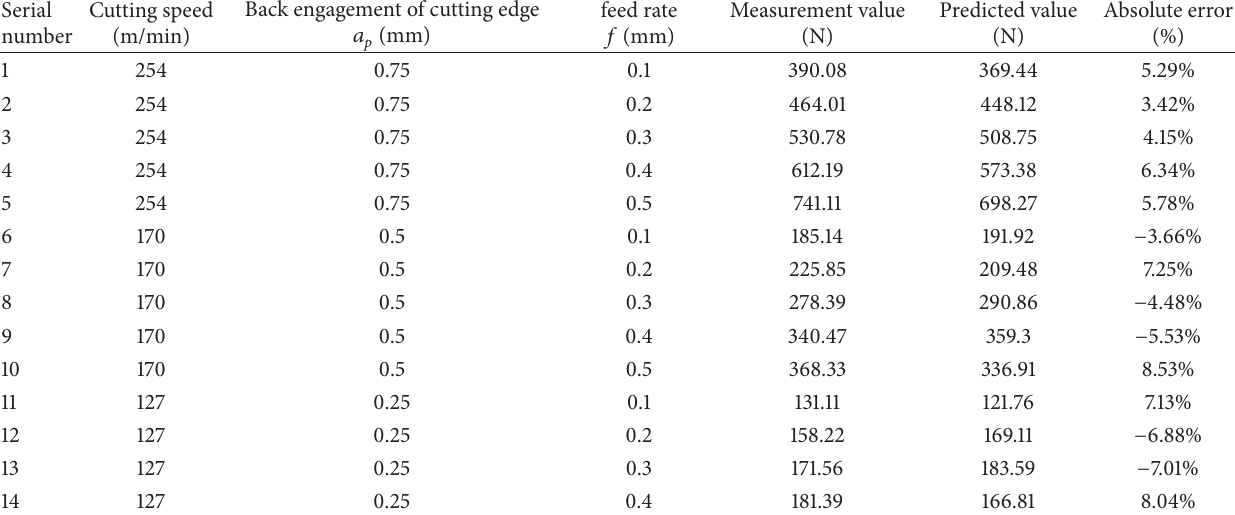
Table 5: The simulation of force average values and the measured average